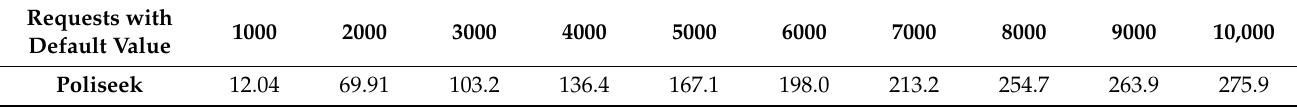
Table 4. Average Evaluation Time of Comprehensive Access Requests. (Evaluation time: